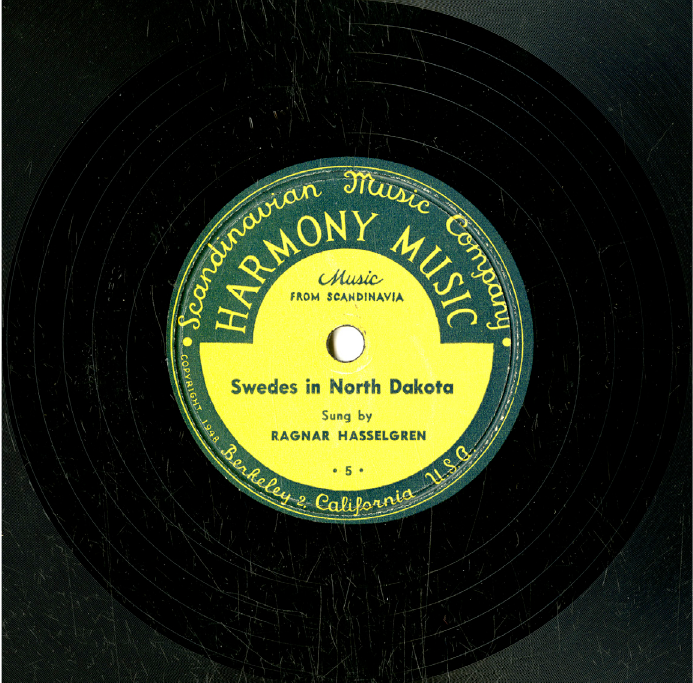
Figure 6: The first commercial recording, with variant title, of the “Swede from North Dakota,” issued in 1948 on the Harmony Music label of Berkeley, California, and performed by Ragnar Hasselgren, son of Swedish immigrants to Montana. (Courtesy of Mills Music Library, University of